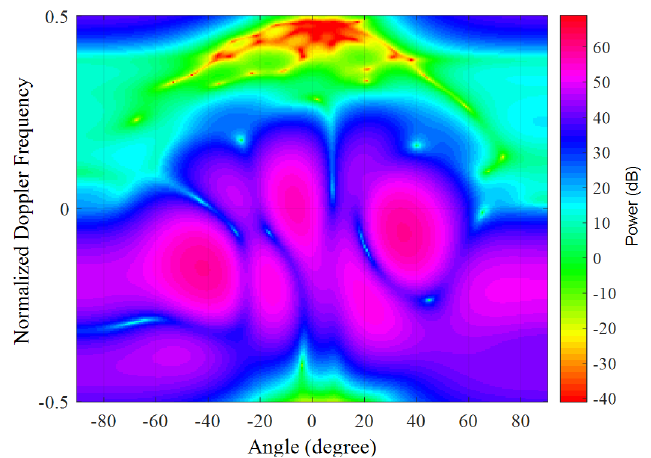
Figure 6. Weight vector response prior to Doppler compensation.